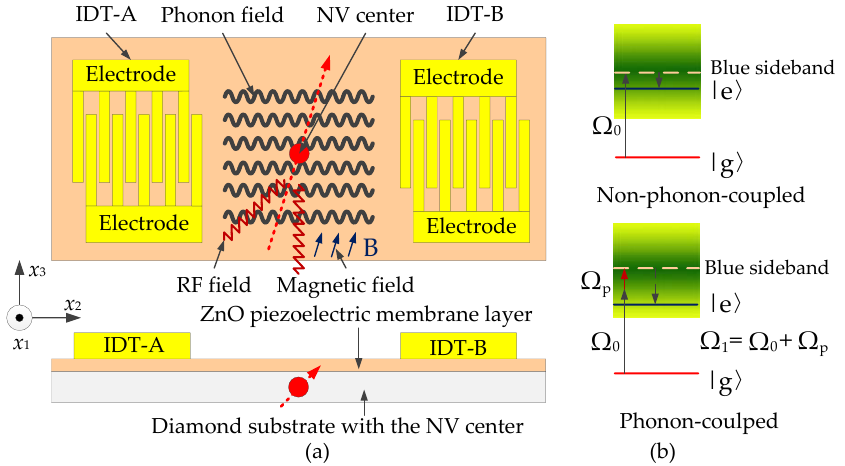
Figure 1. Phonon-coupled resonance structure and manipulation mechanism of the NV center. ( a ) Phonon-coupled resonance structure; ( b ) phonon-coupled manipulation mechanism.